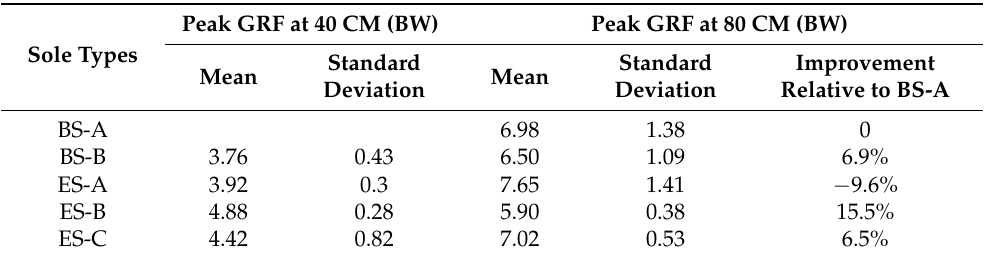
Table 1. Mean and standard deviation of peak vertical GRFs for five soles from drop landing tests at heights of 40 cm and 80